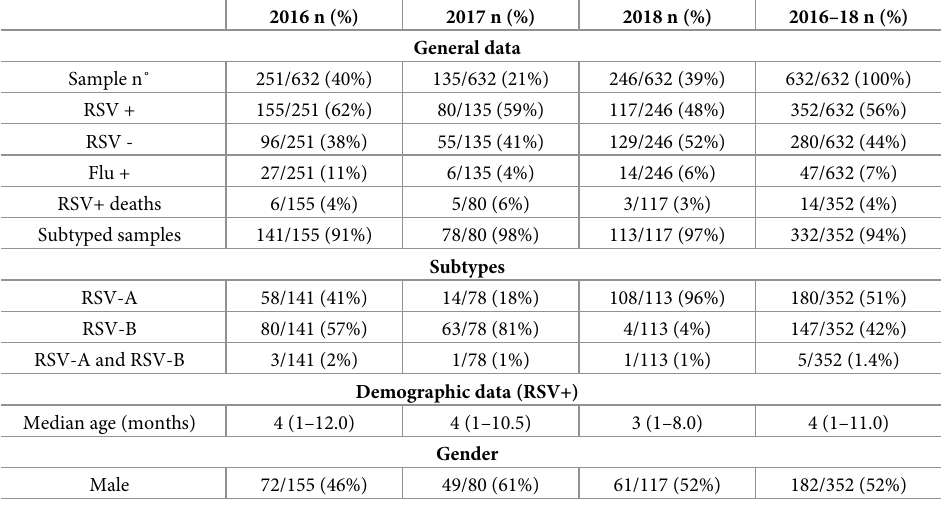
Table 1. Number of tested samples, RSV positivity, subtype prevalence, and demographic data from each year and the whole study period.